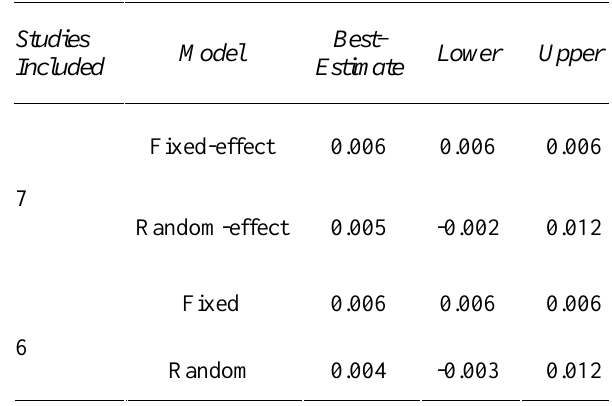
Table 2: Comparison of the results by using different models and including different studies.